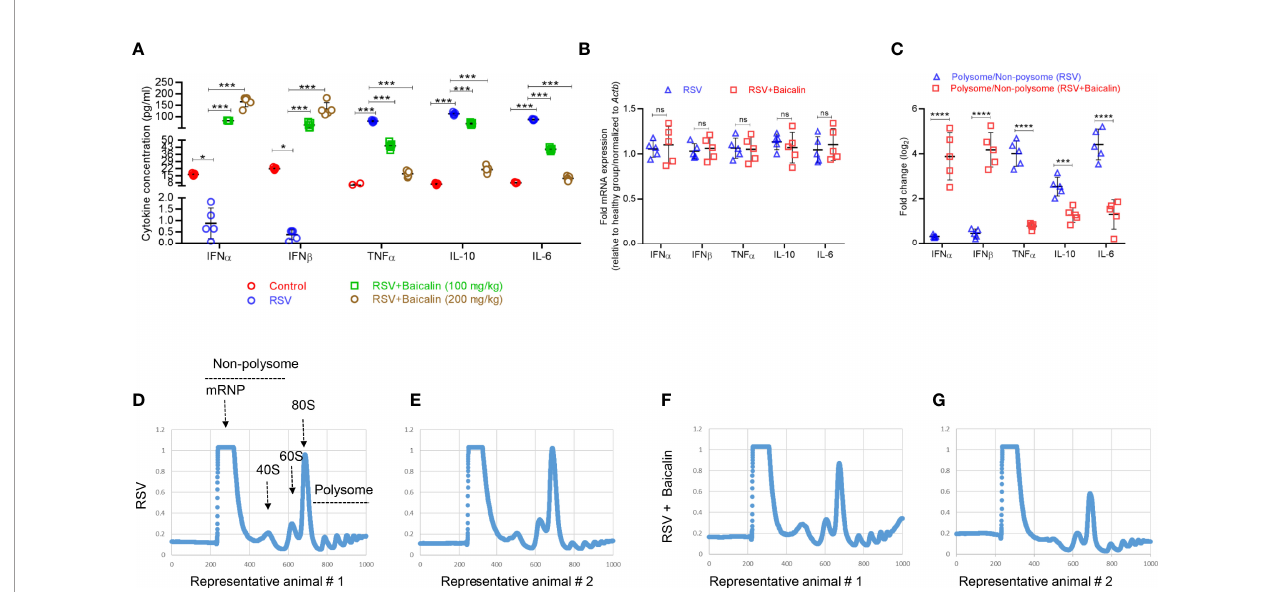
FIGURE 3 | Baicalin promotes type I interferon (IFN) activation. (A) Plasma levels of type I IFNs (IFN- a and IFN- b ) and pro-in fl ammatory cytokines (TNF- a , IL-10, and IL-6) in RSV-infected mice ± baicalin (after fi ve days) were determined by ELISA. (B) Expression of transcripts encoding IFN- a , IFN- b , TNF- a , IL-10, and IL- 6 in lung homogenates recovered from RSV-infected mice, either untreated or treated with baicalin. Data was normalized to Actb expression. (C) Polysomal association of transcripts encoding IFN- a , IFN- b , TNF- a , IL-10, and IL-6 in lung homogenates obtained from RSV-infected mice, either untreated or treated with baicalin. Ribosomal fractions isolated from RSV-infected mice ± baicalin were exposed to 10 – 50% sucrose gradient centrifugation. The puri fi cation of total RNA from each fraction was carried out and then used for RT-qPCR with the gene-speci fi c primers listed in Table 1 . The ratio of polysomal to non-polysomal mRNA amount was evaluated and plotted for each gene. Data shown in A-C represents mean ± SD (n = 5); * P < 0.05, *** P < 0.001, **** P < 0.0001, ns , not signi fi cant – ANOVA with Tukey ’ s post-hoc test. (D – G) Representative polysome pro fi les obtained from lung homogenates of RSV-infected mice, untreated (D, E) or treated with baicalin (F, G) . Similar polysome pro fi les showed that treatment with baicalin did not result in global translation inhibition but instead in transcript- speci fi c inhibition as observed in C